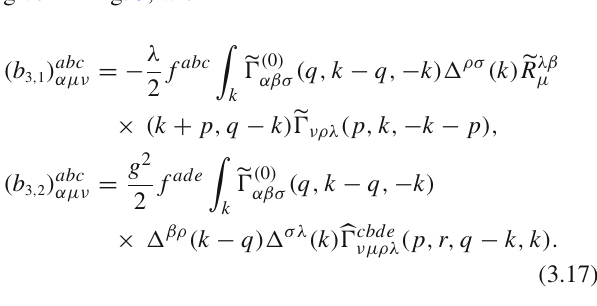
be represented diagrammatically by a blue circle (see,